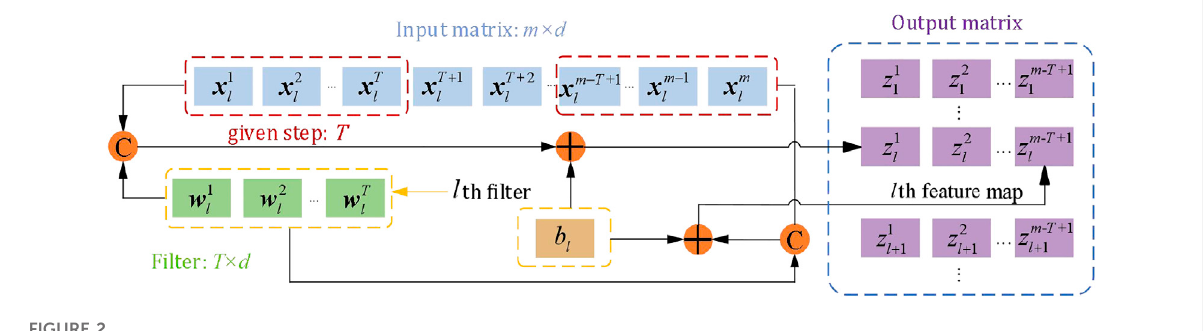
FIGURE 1 Architecture of the forecasting model.